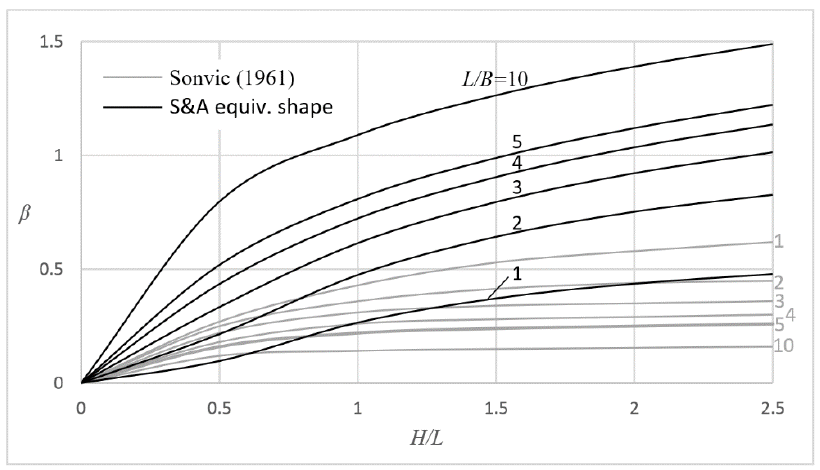
Figure 2. Comparison chart between Sovinc’s [8] factor for rigid rectangular footing ( ν = 0.5) and the respective one based on Schiffman and Aggarwala ([18]; denoted as S&A on the figure) equivalent ellipse.